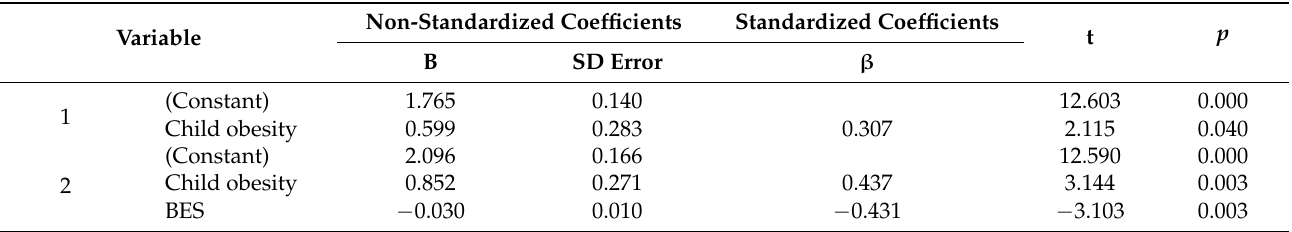
Table 4. Linear regression analysis.